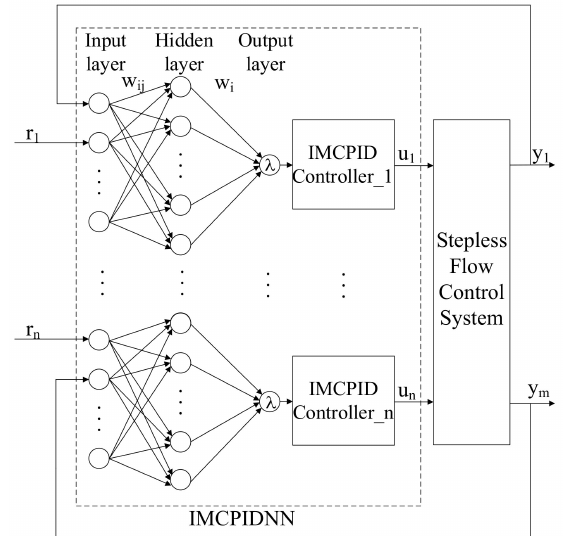
Figure 5. The block diagram of a MIMO nonlinear system with BP neural